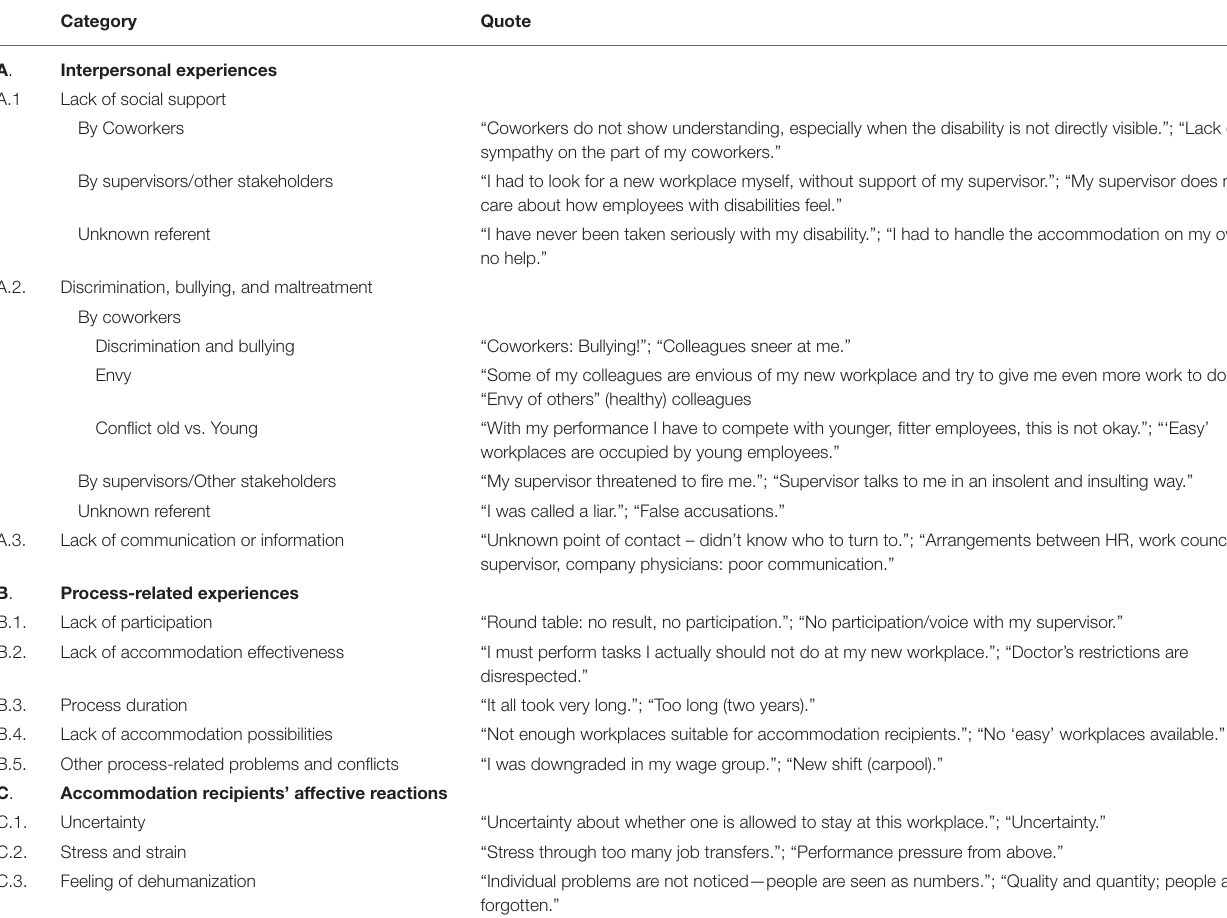
TABLE 2 | Quotes of recipients’ negative